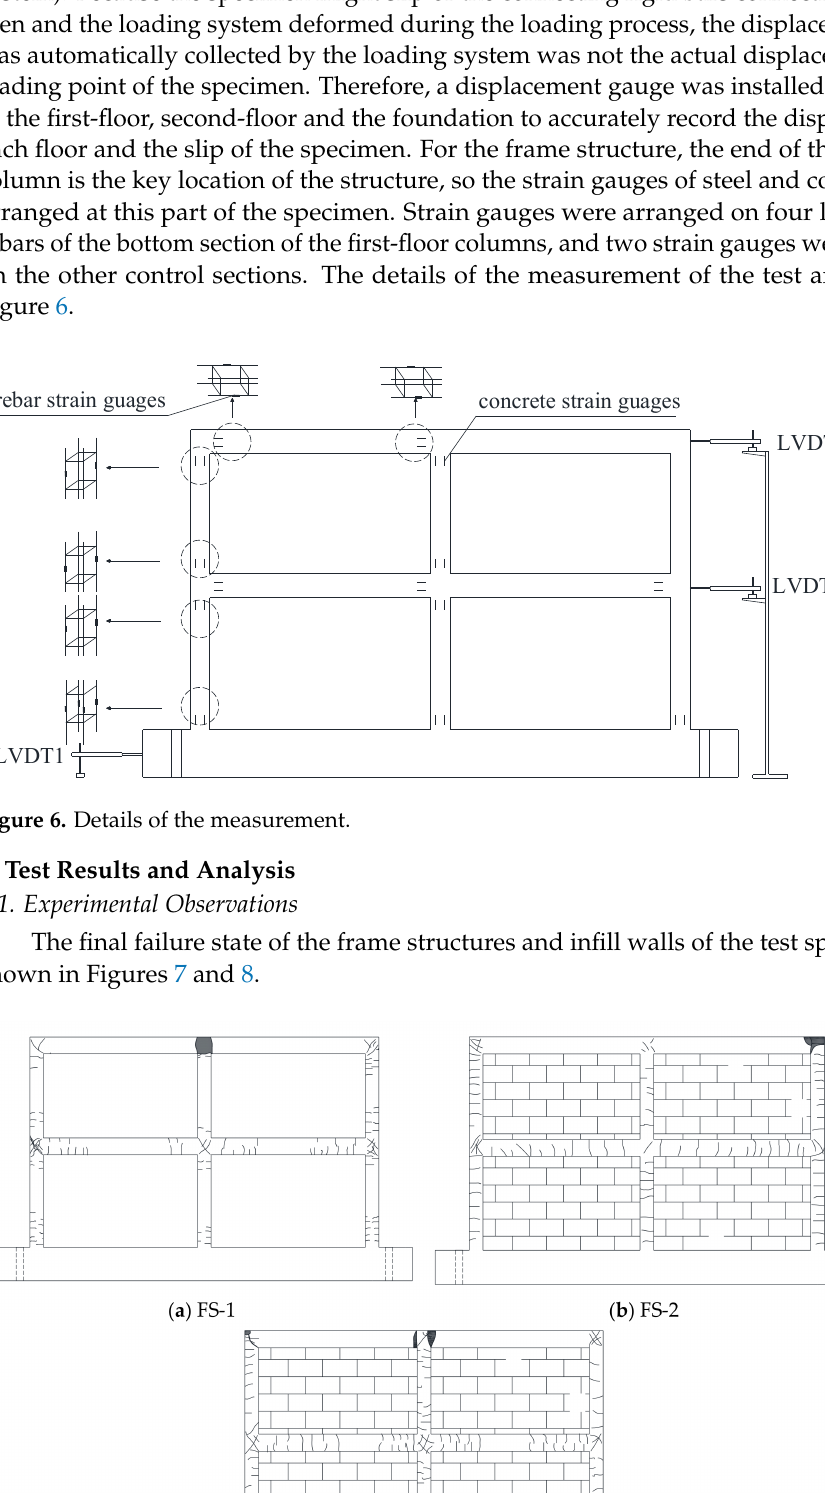
Figure 7. Crack patterns of